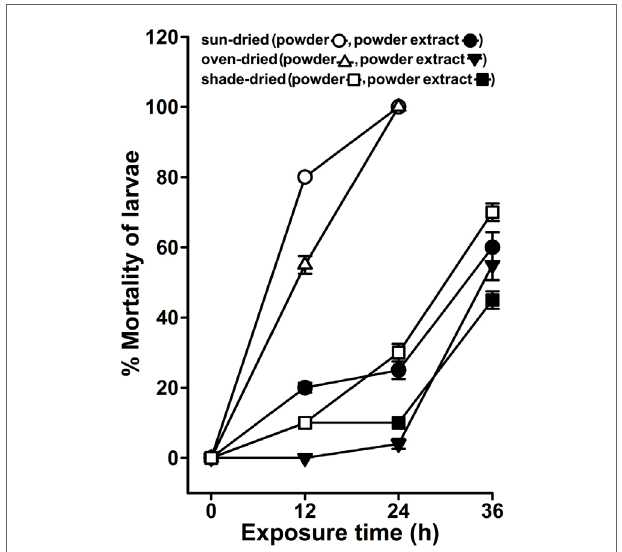
FigUre 8 | The larvicidal activity of Agave dried powder formulation. Agave angustifolia leaves with active larvicidal activity were either sun-, oven-, or shed-dried and the powder was prepared. The powder was stored at room temperature under moisture-free conditions for 3 months (the shelf life of the powder). A. aegypti larvae were exposed to the powder-free aqueous extracts or powder directly added to the water in the amount equivalent to the fresh leaves exhibiting the larvicidal activity as mentioned in Figure 4 . The percentage mortality of the larvae at each time point was calculated against sham-treated controls (not shown here) and represented as the mean ± SD of